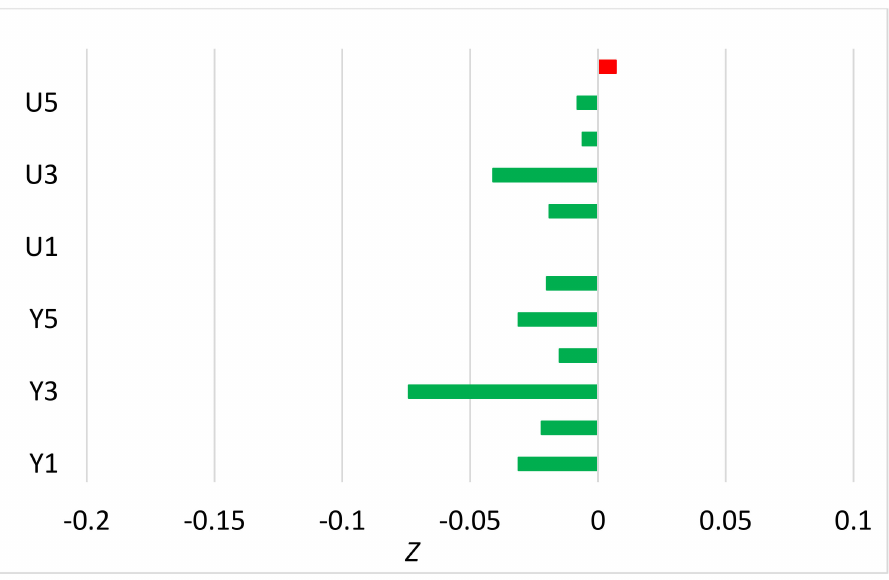
Figure 2. The same as Figure 1, but for the annual RMSE of individual